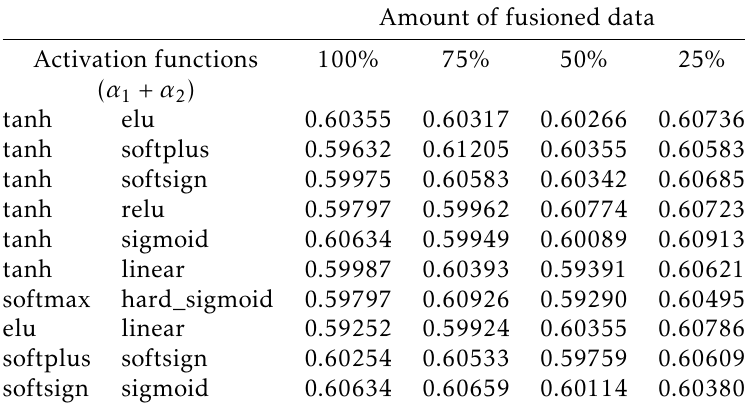
Table 5. Tuple of the ten highest activity recognition model results for Subject 4, which benchmark is 0.60025.